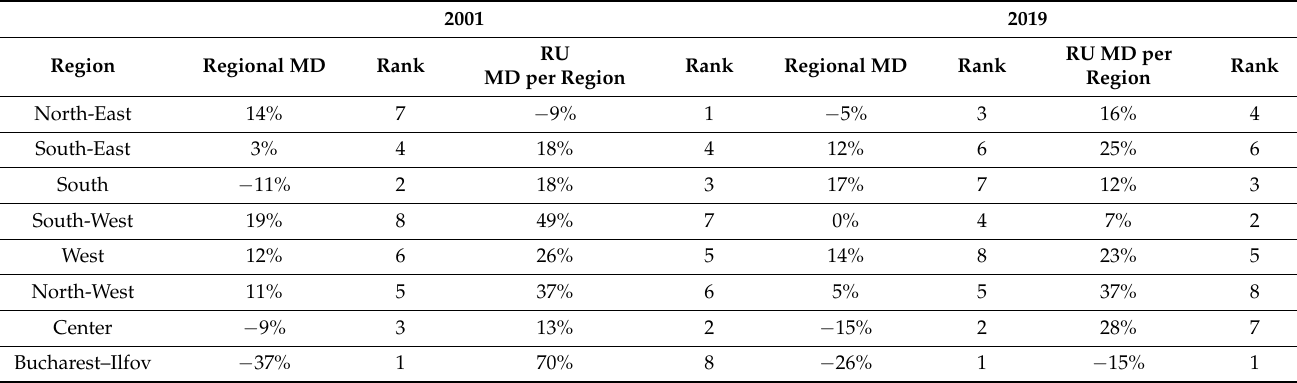
Table 4. Mortality difference by region and urban–rural